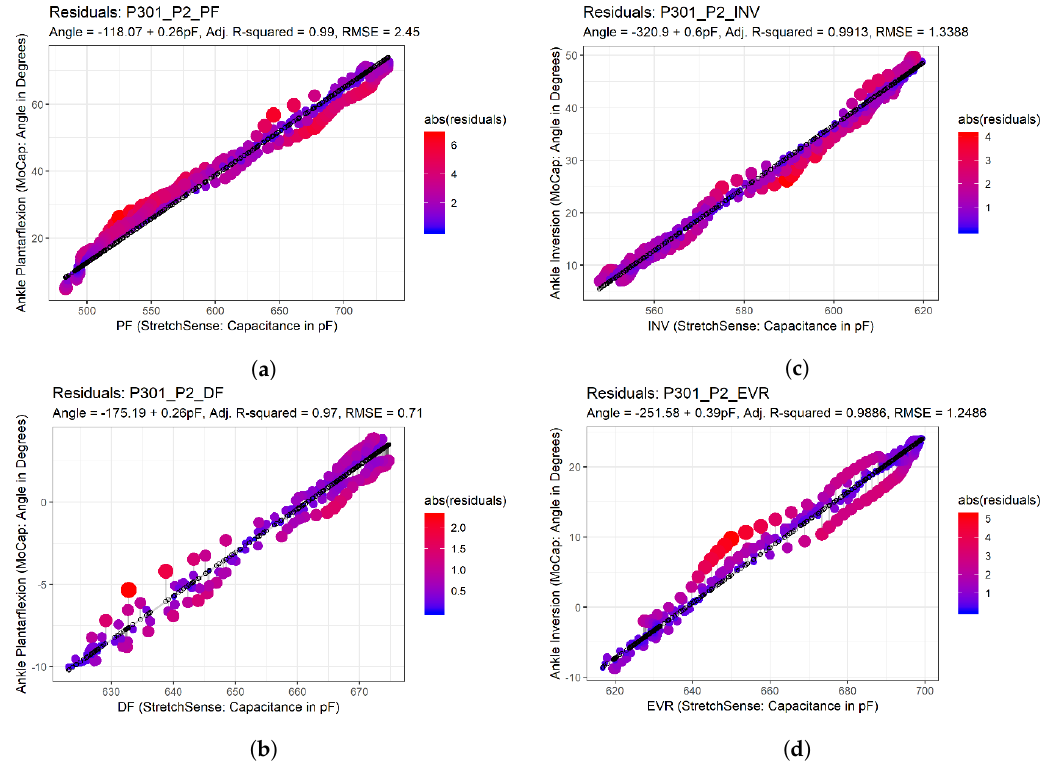
Figure 8. Residual plots: ( a ) residual plot for Plantar flexion movement at POC 2; ( b ) residual plot for Dorsiflexion movement at POC 2; ( c ) residual plot for Inversion movement at POC 2; and ( d ) residual plot for Eversion movement at POC